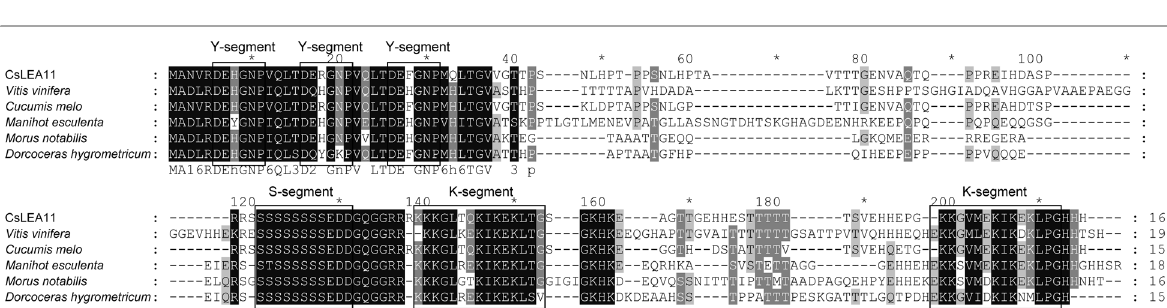
Fig. 2 Sequence alignment of CsLEA11 protein with homologs from other plant species performed with the NCBI database. Accession Numbers are as follows: Vitis vinifera (XP_002283605.1), Cucumis melo (XP_008460975.1), Manihot esculenta (AGC51773.1), Morus notabilis (XP_010105346.1), and Dorcoceras hygrometricum (KZV53366.1). The multiple amino acid sequence alignment reveals the common features of CsLEA11 and other DHNs, such as the Y-, S- and K-segments, which are